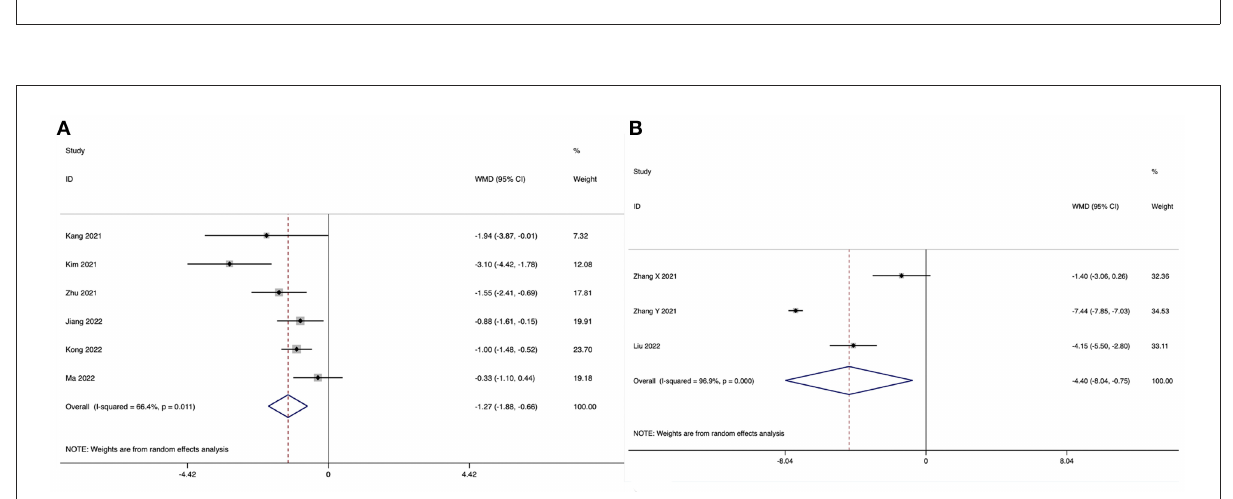
FIGURE3 Forest plot of the operating time. (A) ULIF vs. MI-TLIF; (B) ULIF vs. PLIF.